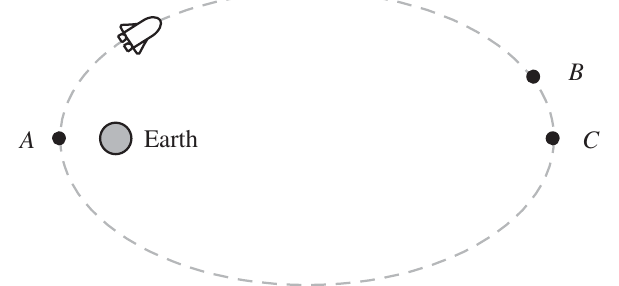
FIG. 2. The orbits problem. Students were asked to determine whether the kinetic and potential energy of the spacecraft-Earth system each increase, decrease, or stay the same as the spacecraft moves from point A to point B .